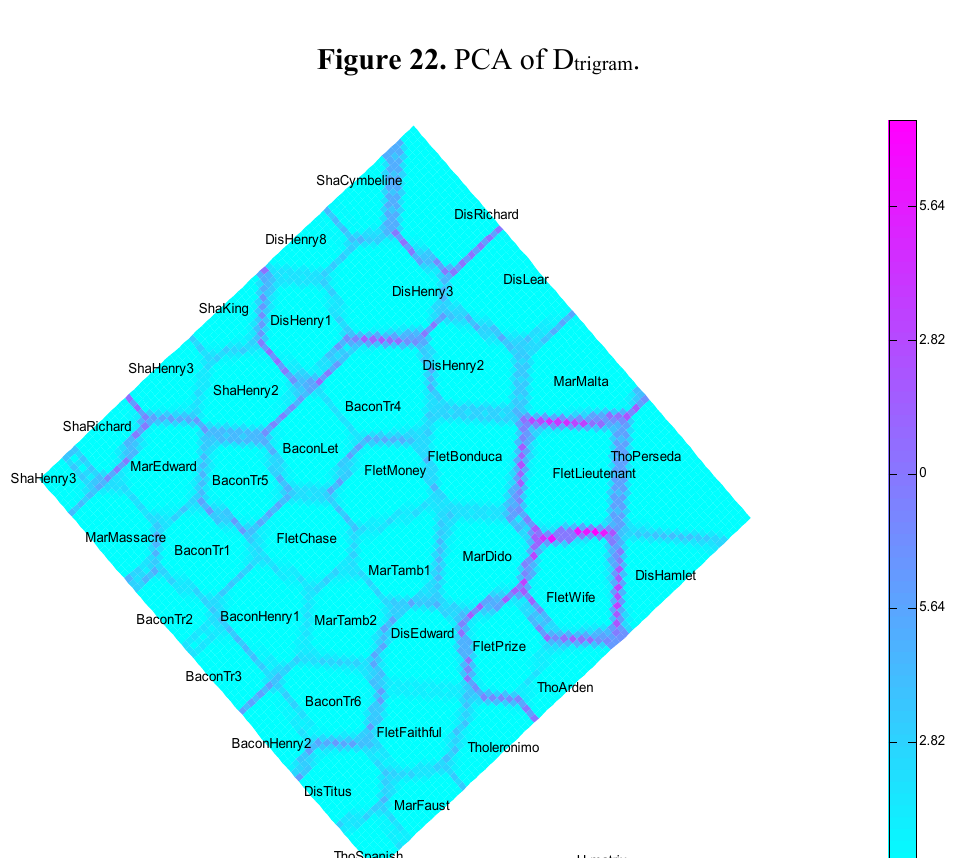
Figure 22. PCA of D trigram .